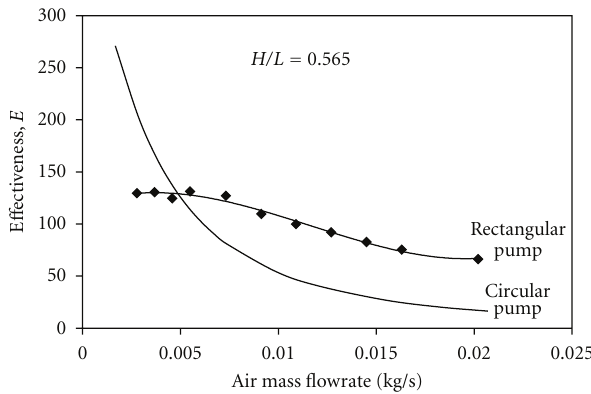
Figure 4: Comparison of the e ff ectiveness, E , of circular and rectangular pumps at submergence ratio H/L = 0 . 565.